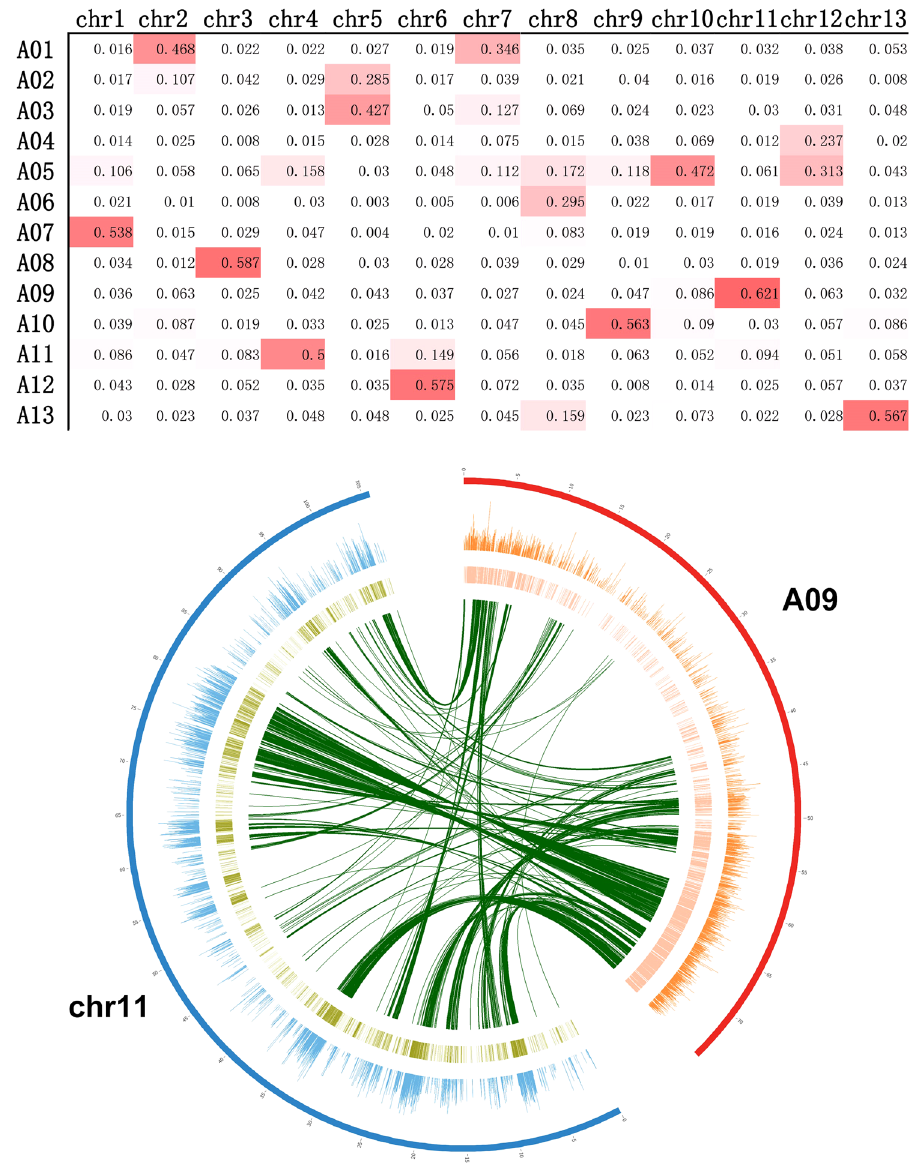
Figure 2. Conservation between diploid and allotetraploid cotton. ( A ) The red or white boxes stand for the ratio of orthologous gene pairs between each chromosome from G. arboreum (chr1-chr13) and G. hirsutum (A01-A13). ( B ) A comparison of H3K4me3, gene expression and orthologue between each pair of chromosomes. Data are displayed with circos software using four layers: the outer circle stands for the A09 (red) and chr11 (blue) chromosome, the second circle stands for H3K4me3 modification peak distribution along A09 (orange) and chr11 (blue), the third circle stands for gene expression density (high expression indicated by a dark colour) among A09 (pink) and chr11 (green), and the curves of the inner layer link orthologous genes in the two